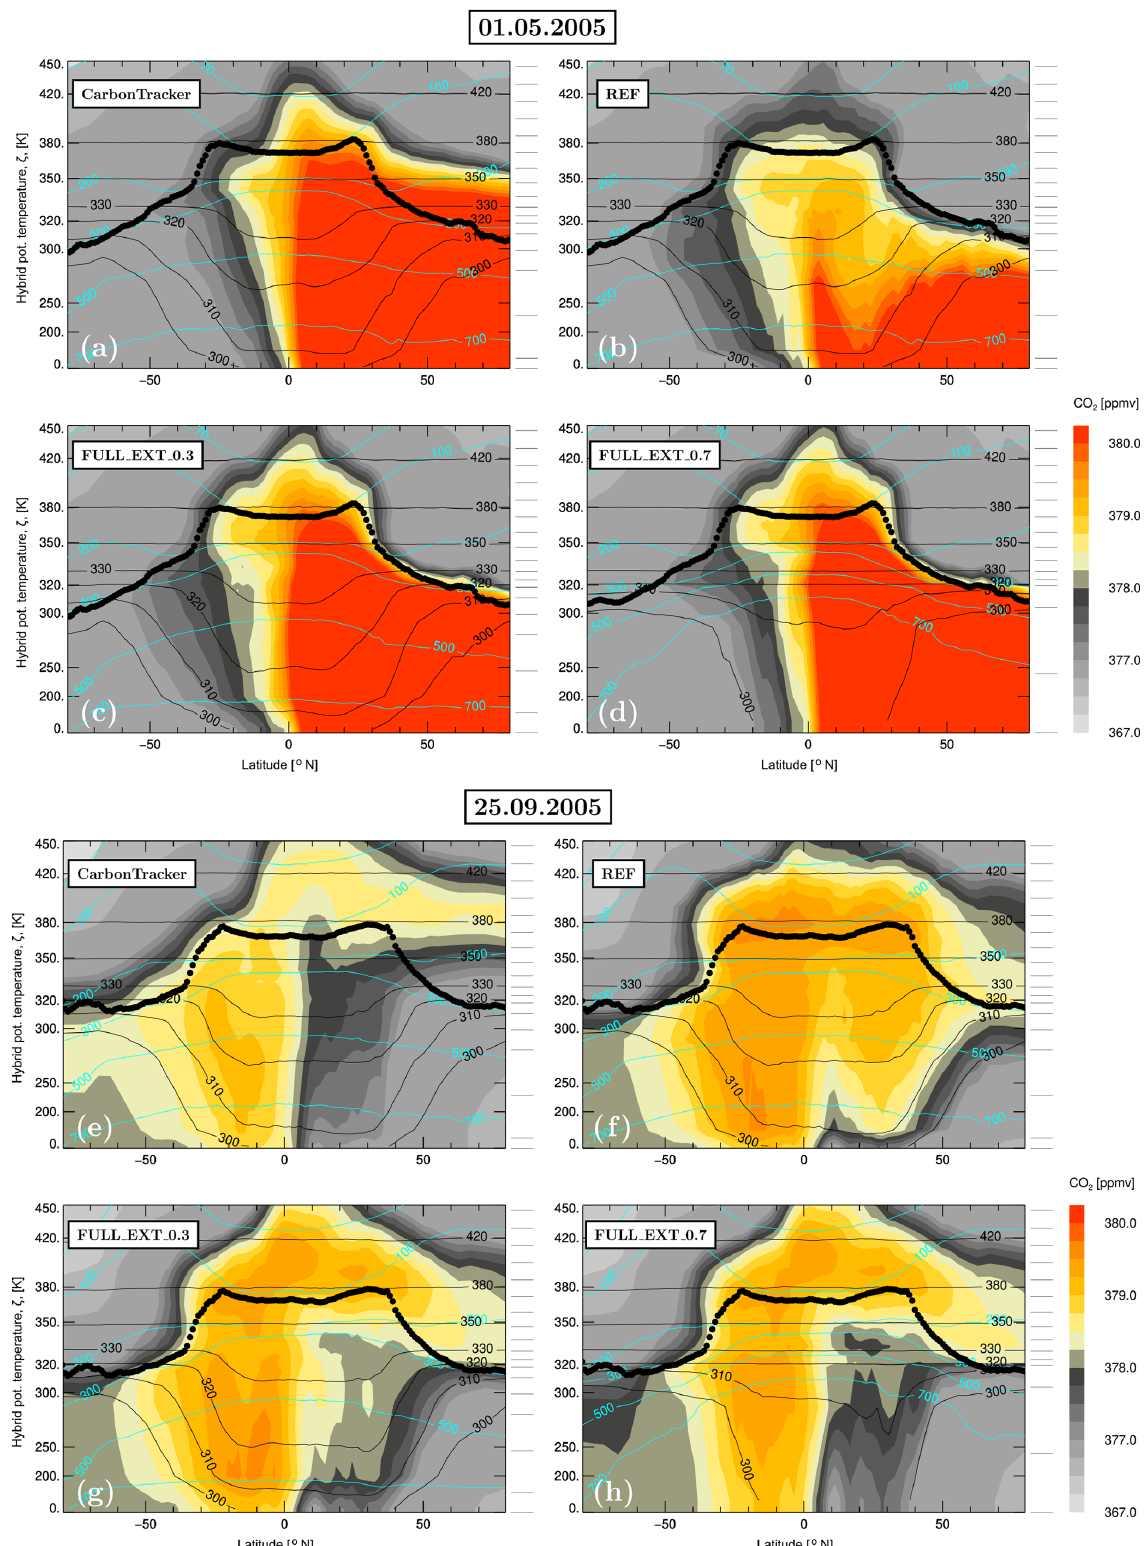
Figure 9. Upward propagation of the CO 2 distribution from the lowest layer of the model where CO 2 was initialized by the CarbonTracker data (CT2013B) on two days: 1 May 2005 (a–d) and 25 September 2005 (e–h) . The CLaMS zonal means for different model configurations are compared with the CarbonTracker distribution itself. Black dots denote the tropopause derived from the ERA-Interim